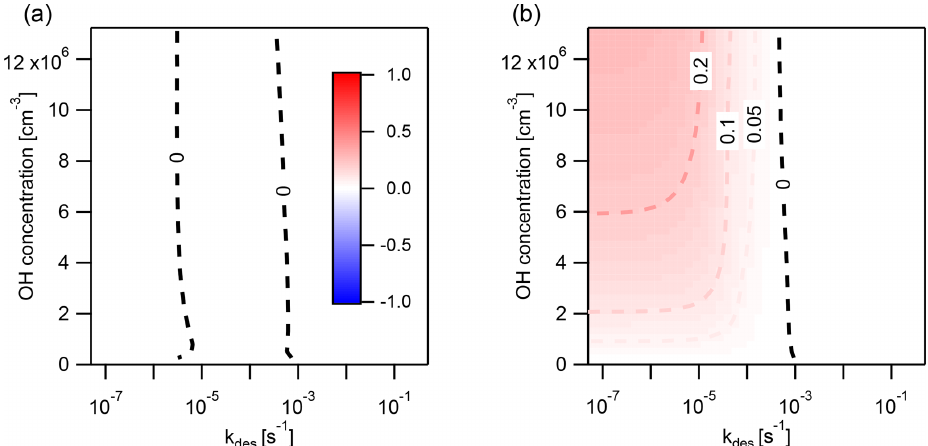
Figure A4. Discrepancy, determined with the error metric E loss , between the explicitly coupled (EC) solution and the operator-splitting (IE) solution with a time step of (cid:49)t = 30min for the reaction of OH (1ppt) with (a) both gas- and particle-phase pyrene and (b) only gas-phase pyrene. Regions where EC overestimates the loss of pyrene are indicated in red (0 < E loss ≤ 1) and underestimated in blue ( − 1 ≥ E loss < 0). The conditions are 280K and 1 × 10 3 particlescm − 3